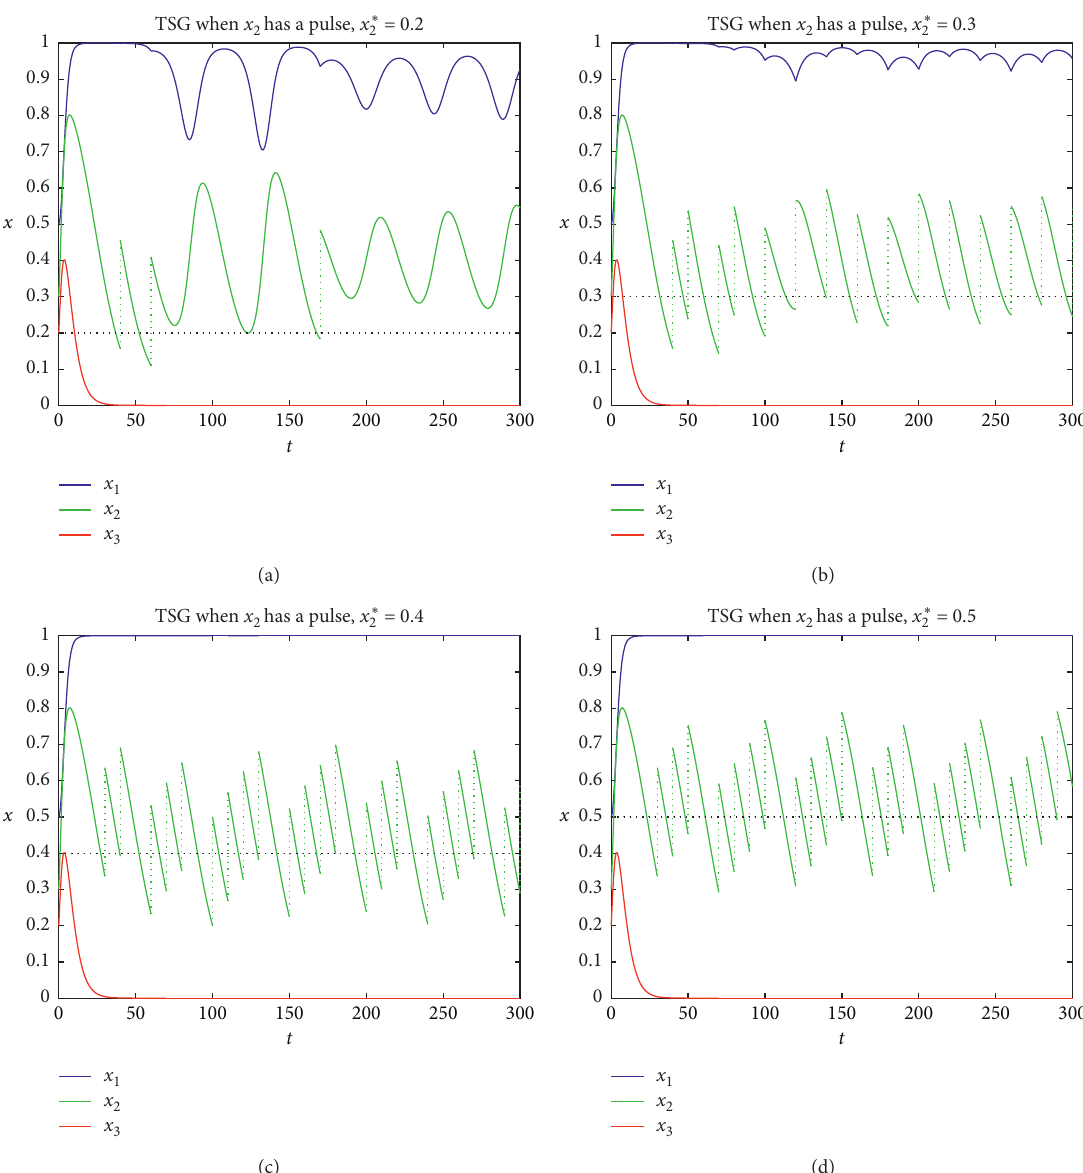
,x , x )| � P ( 0 . 5 , 0 . 3 , 0 . 2 ) . (a) x ∗ t � 0 1 2 3 0